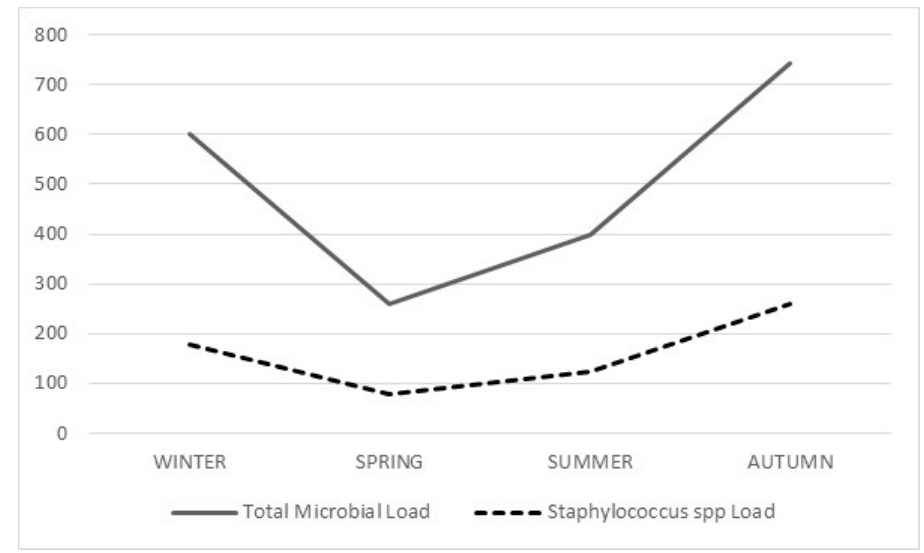
Figure 1. Seasonal variability of total microbial load and of Staphylococcus spp.